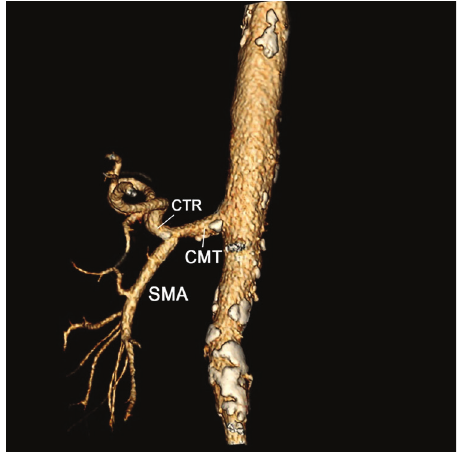
Figure 6 - Three-dimensional reconstruction CTA image shows a variation of CHA from SMA origin.